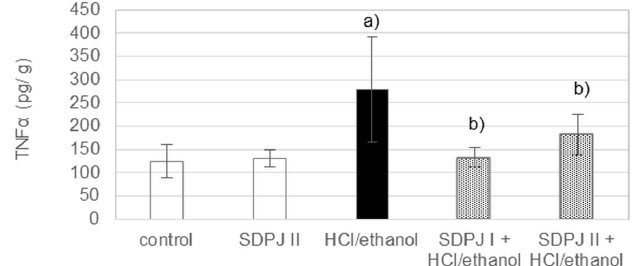
Figure 6. Effect of spray-dried potato juice (SDPJ) on level of gastric TNF- α in rats treated with the mixture of HCl/ethanol. SDPJ I: SDPJ 200 mg/kg. SDPJ II: SDPJ 500 mg/kg. HCl/ethanol: the mixture of 0.3 M HCl and 60% ethanol (1:1). Values represent the means ± SD ( n = 8). a) p < 0.05 vs. the untreated group. b) p < 0.05 vs. the HCl/ethanol-treated group.